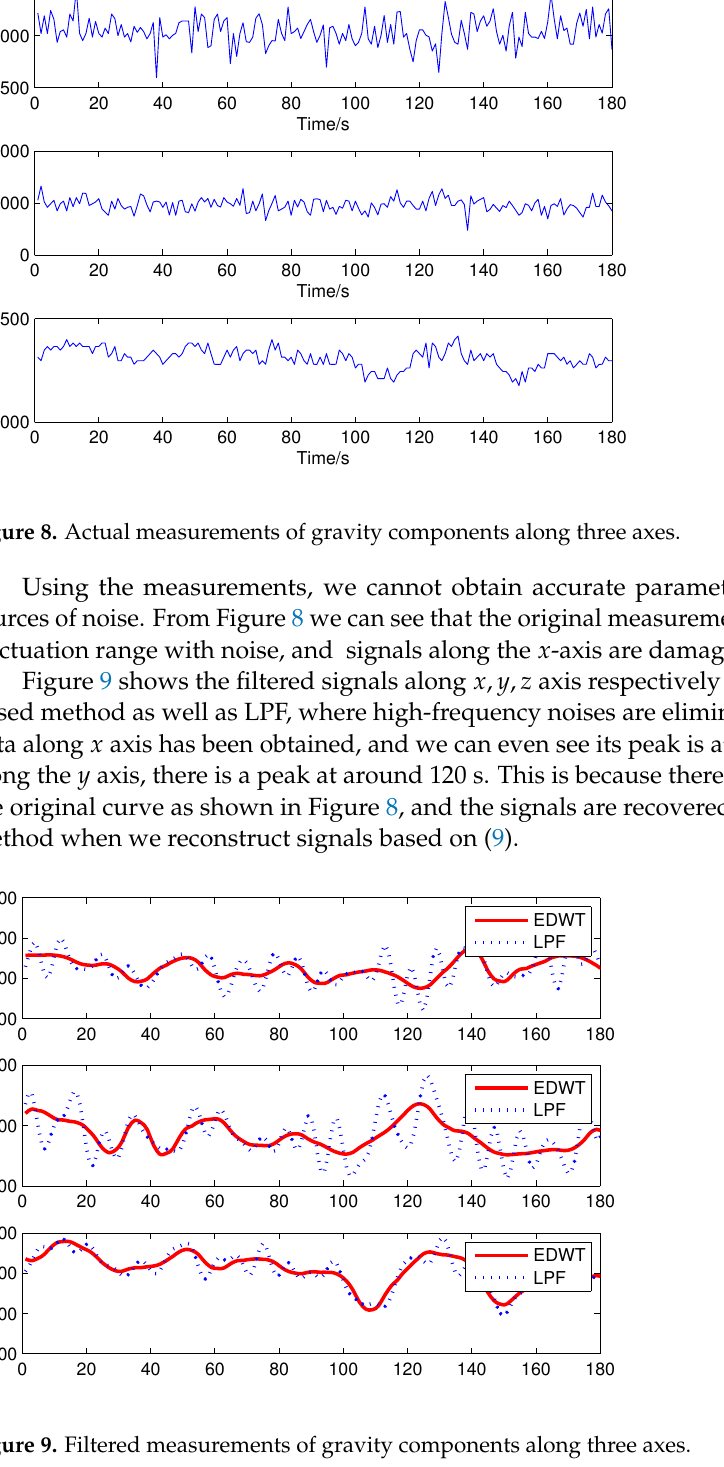
Figure 9. Filtered measurements of gravity components along three axes. Then based on (6) and (7), the plots of inclination angle measurements and filtered inclination angles are given in Figure 10. We can see that the filtered curve using EDWT is flat and steady with accuracy between ± 2 ◦